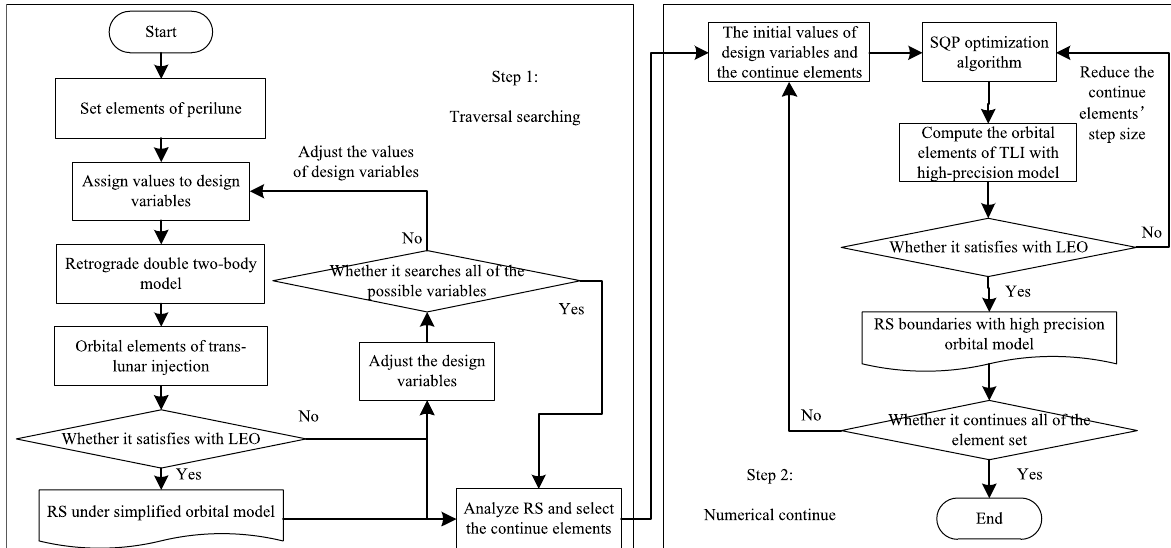
Fig. 3 Flow chart of the frame suggested for generating the reachable set of the trans‑lunar orbits